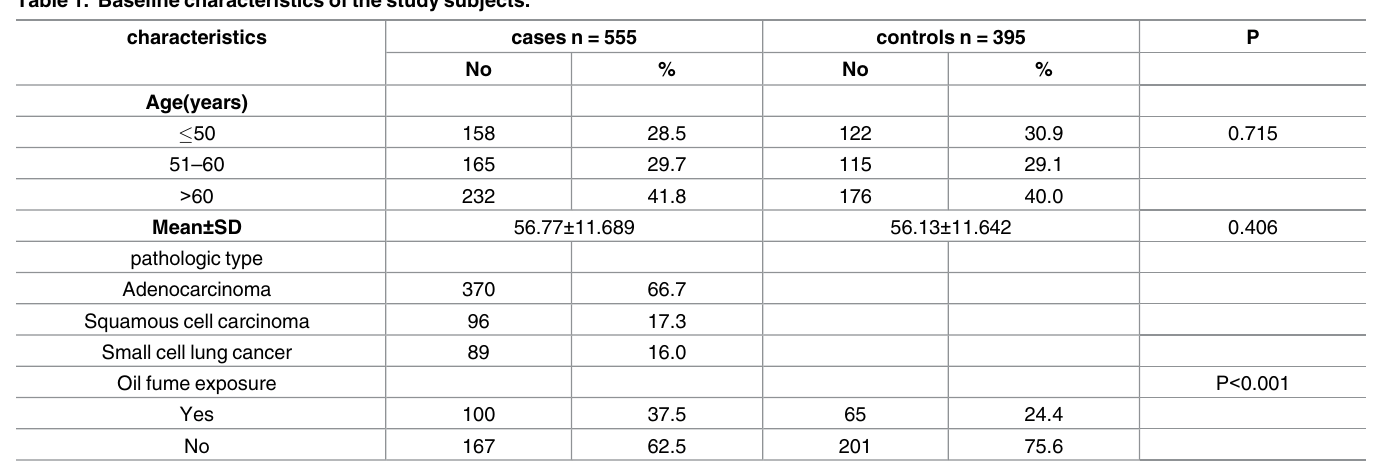
Table 1. Baseline characteristics of the study subjects.